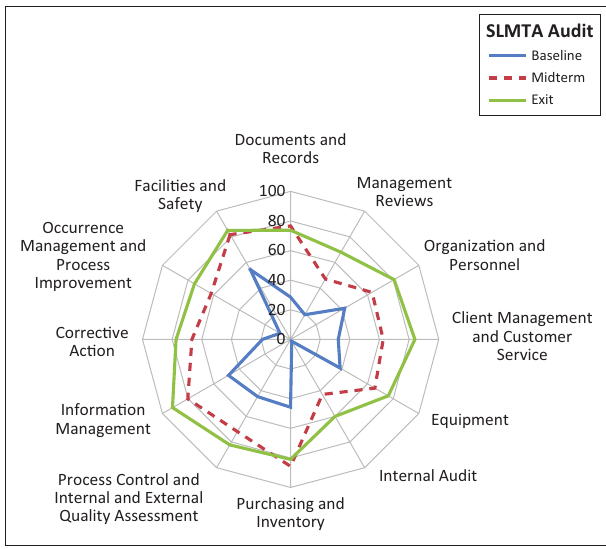
FIGURE 4: Mean quality system essential scores for Kenya National Blood Transfusion Service